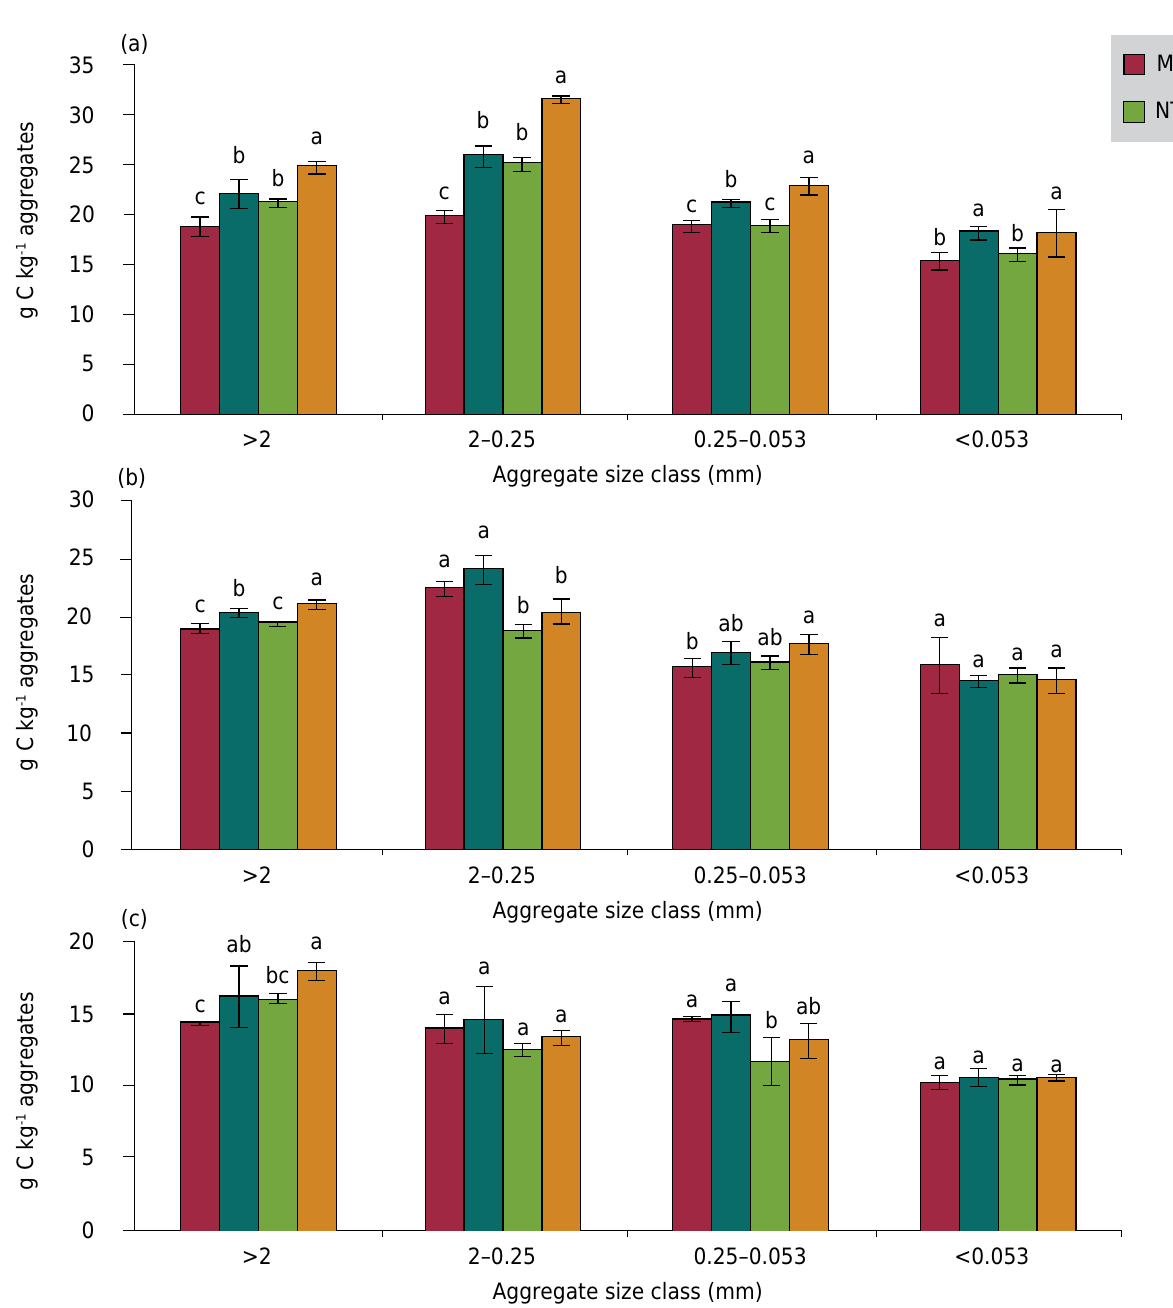
Figure 2. Aggregate-associated SOC concentration in different layer intervals as influenced by tillage treatments. (a) 0.00-0.05 m; (b) 0.05-0.20 m; (c) 0.20-0.30 m. MP-S: moldboard plow without straw; MP+S: moldboard plow with straw; NT-S: no-tillage without straw; NT+S: no-tillage with straw. Error bars represent standard errors of the means (n = 3). Different lower-case letters within an aggregate size indicate significant differences between treatments according to Duncan’s test